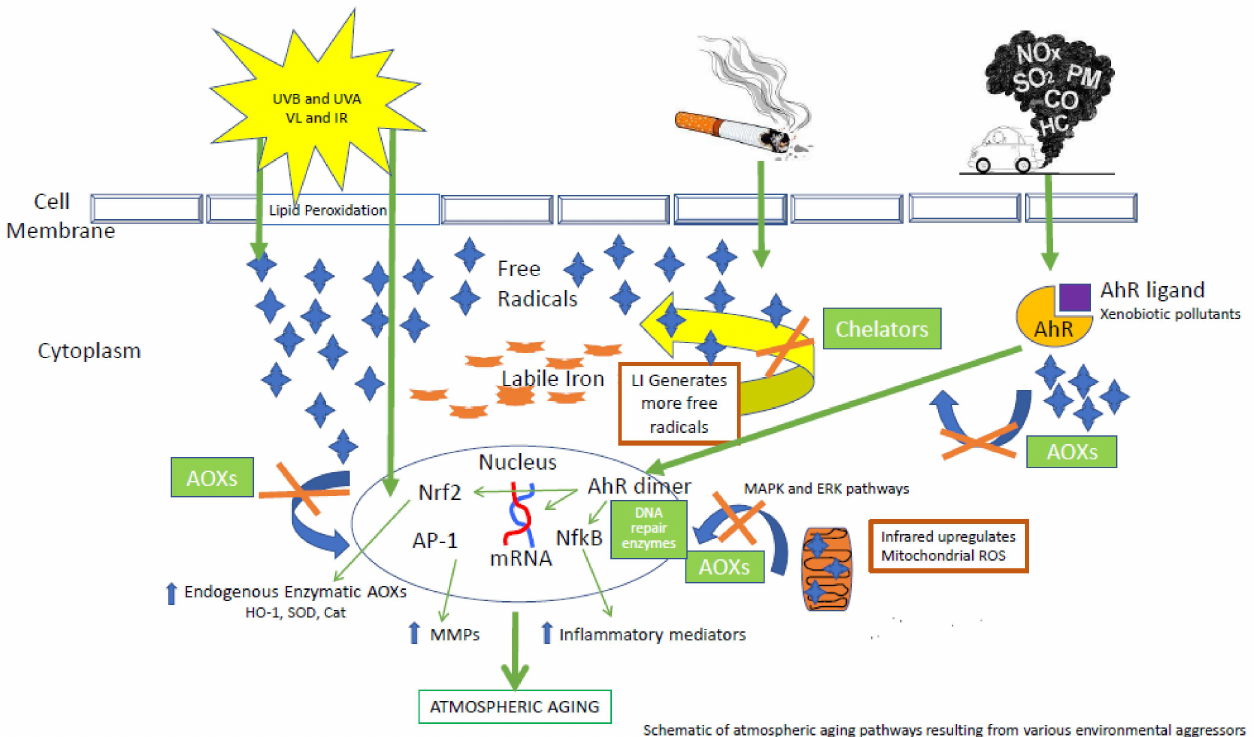
Figure 1. The skin is exposed to a variety of environmental aggressors including solar radiation, cigarette smoke and pollutants that increase directly or indirectly the production of reactive oxygen species (ROS). Exposure to infrared light (IR) upregulates mitochondrial ROS, further increasing intracellular ROS accumulation. In addition, both UV light and pollution increase intracellular free iron, or labile iron (Fe(II)-ion), which further catalyzes formation of ROS. As ROS accumulate within the cell, they overwhelm the intrinsic antioxidant defense system, triggering oxidative stress. Oxidative stress upregulates redox sensitive transcription factors, such as activator protein 1 (AP-1) involved in transcribing for collagen degrading matrix metalloproteinases (MMPs) and nuclear factor kappa beta (NF- к β ), master regulator of the pro-inflammatory cytokines production. Polycyclic aromatic hydrocarbons (PAHs) in particulate matter are ligands of aryl hydrocarbon receptors (AhR). PAHs activate AhR that translocate to the nucleus and after binding to the DNA (xenobiotic- responsive element) induces the transcription of detoxifying enzymes that are able to increase the ROS levels and further activate redox sensitive transcription factors, such as NF- к β and nuclear factor erythroid 2- related factor 2 (NRF2). Prevention strategies include antioxidants (AOXs) that can be delivered topically or through nutrition to increase the skin’s ability to neutralize ROS. Topically applied chelators can also be used to bind metals, thus preventing ROS